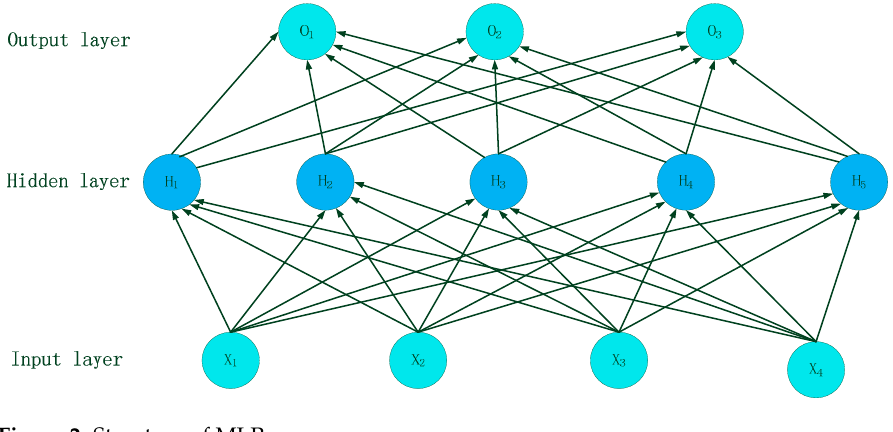
Figure 2. Structure of MLP.